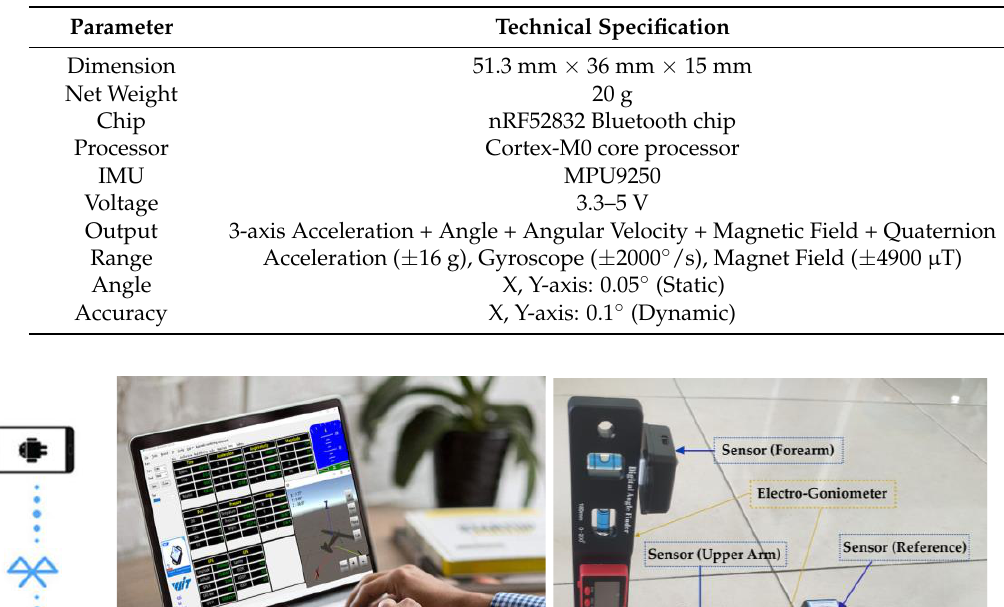
Table 1. IMU specifications. Source: https://www.wit-motion.com/. Accessed on 5 September 2022.